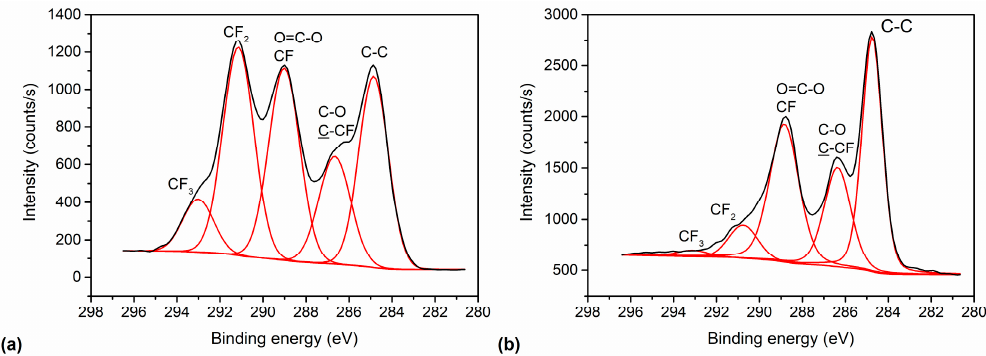
Figure 4. Deconvolution of C 1s spectra: ( a ) below and ( b ) above the threshold pressure.